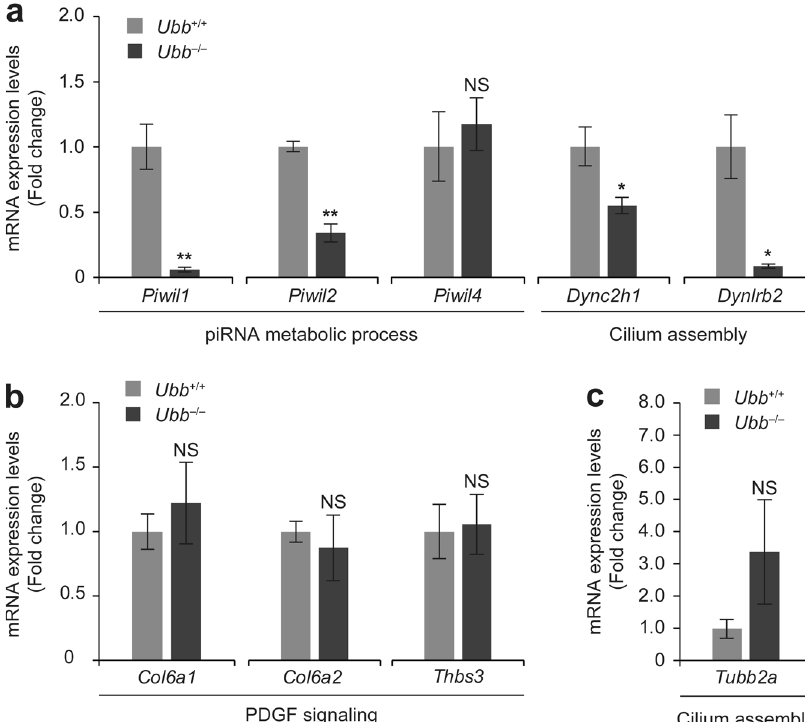
Fig. 4 Altered gene expression of testicular DEPs. Based on proteomic analysis, several mRNA levels of Ubb + / + (WT) and Ubb − / − testis were determined using qRT-PCR. a Among downregulated proteins, expression levels of their genes involved in the piRNA metabolic process ( Piwil1 , Piwil2 , and Piwil4 ) and cilium assembly ( Dync2h1 and Dynlrb2 ) were compared between Ubb + / + and Ubb − / − testis ( n = 3 each). b Among upexpressed proteins, expression levels of their genes involved in PDGF signaling ( Col6a1 , Col6a2 , and Thbs3 ) were compared between Ubb + / + and Ubb − / − testis ( n = 3 each). c The expression level of Tubb2a , which was involved in cilium assembly, increased in Ubb − / − testis as compared to that in WT testis ( n = 3 each). All mRNAs used were isolated from Ubb + / + or Ubb − / − testes, which were collected from mice at postnatal day 20 (P20). All expression levels of genes were normalized to Gapdh level, and data are expressed as the mean ± SEM of indicated number of samples. * P < 0.05; ** P < 0.01 vs. Ubb + / + . NS not signi fi